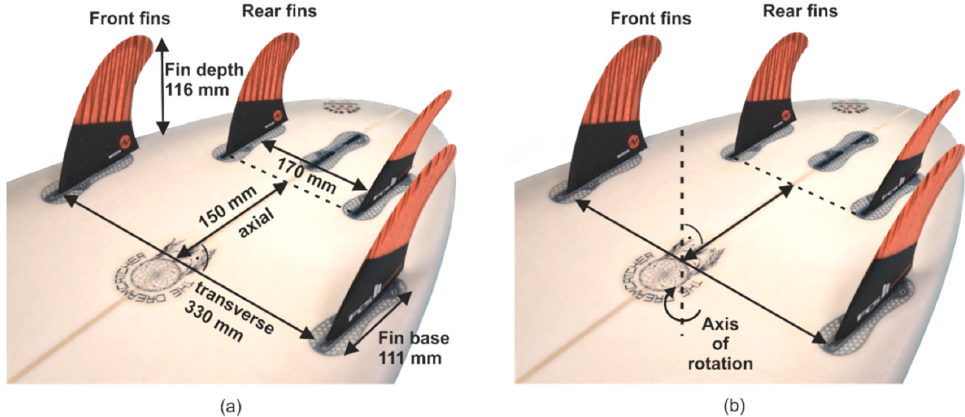
Figure 6. ( a ) Dimensions of the initial commercial 4-fin configuration in the axial and transverse direction with fin depth and base. ( b ) The position of the axis of rotation to realize the AoA.